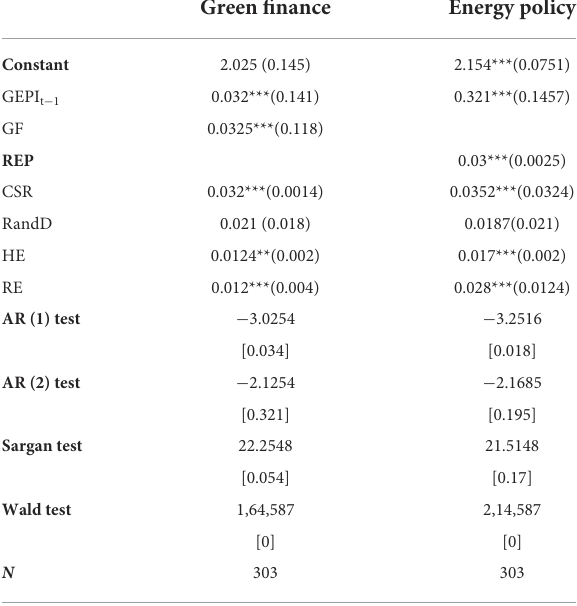
TABLE 5 The result of the panel data regression.